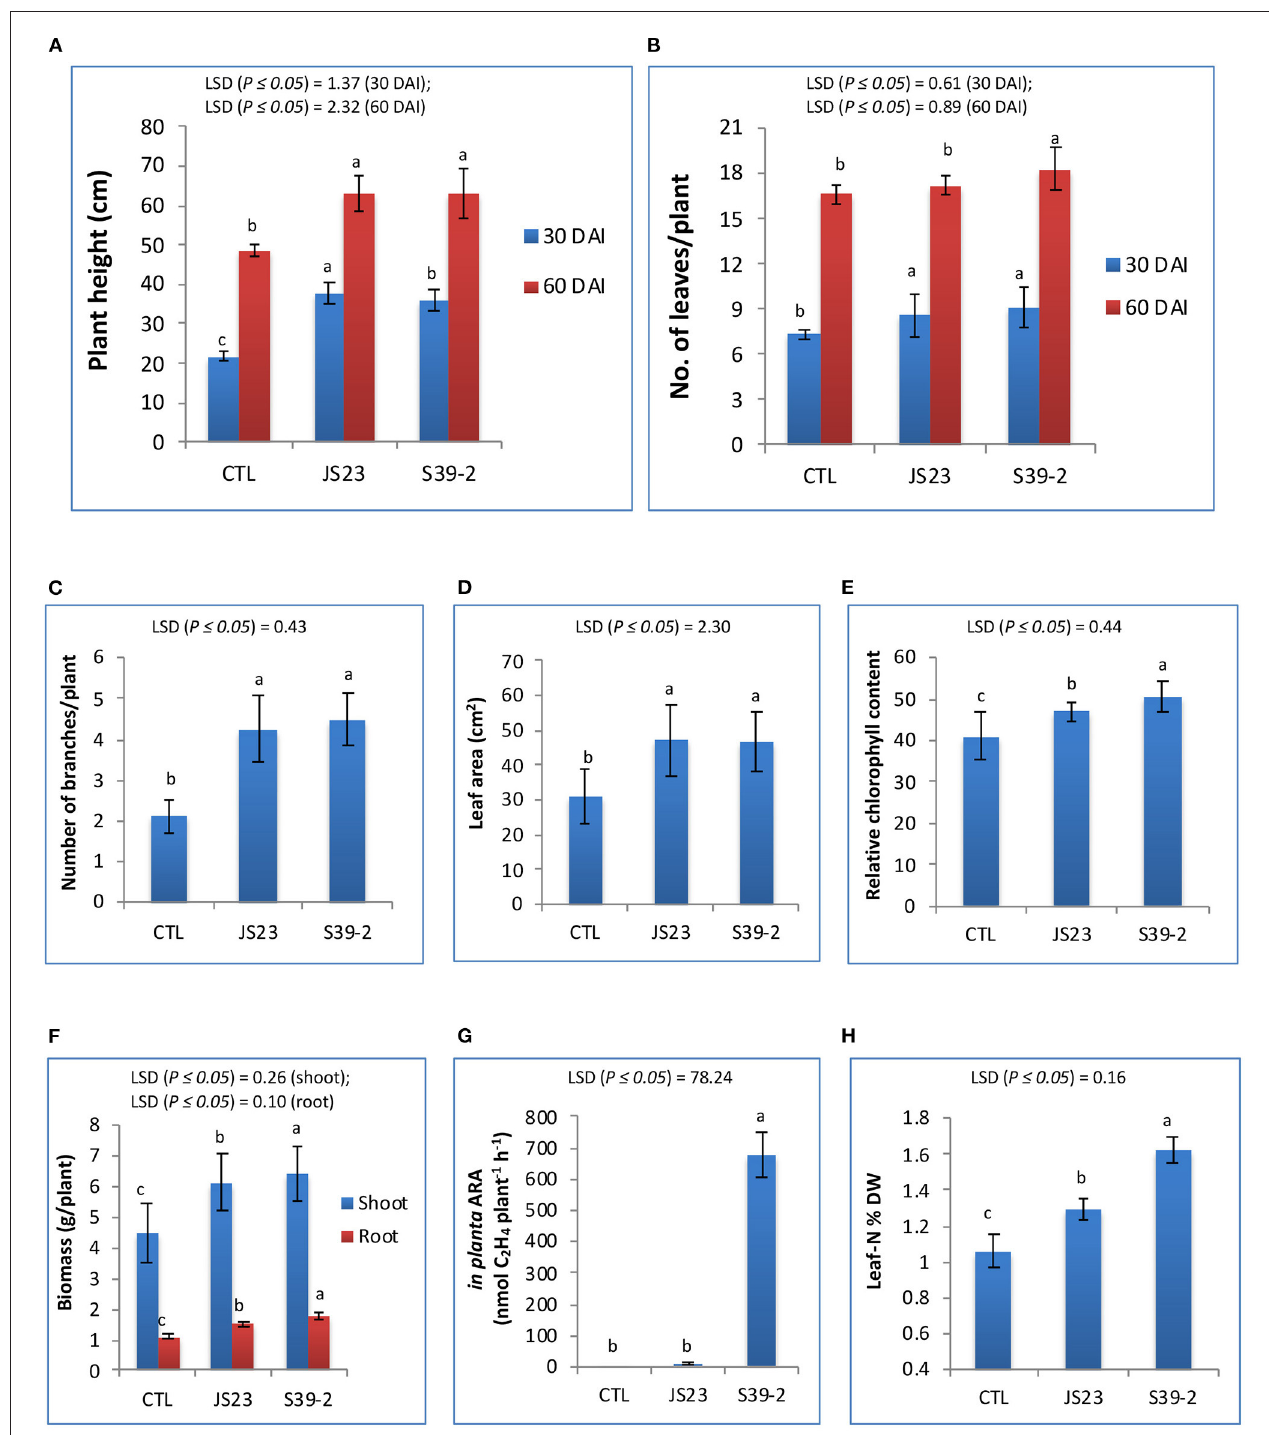
FIGURE 4 | PGP effects of non-diazotrophic and diazotrophic isolates on eucalyptus seedlings. The effect on plant height (A) , number of leaves (B) , number of branches (C) , leaf area (D) , relative chlorophyll content (E) , total biomass of leaves, stems and roots (F) , in planta AR activity (G) and leaf N content (H) was measured at 30 and 60 DAI with strain JS23 T in lemon eucalyptus grown in small pot containing 750g of red soil. Mean values ± SD are presented ( n = 18). The data were statistically analyzed using DMRT. Different letters indicate significant differences of the treatments according to least significant difference (LSD) at p ≤ 0.05 levels. DAI , days after inoculation; CTL , uninoculated